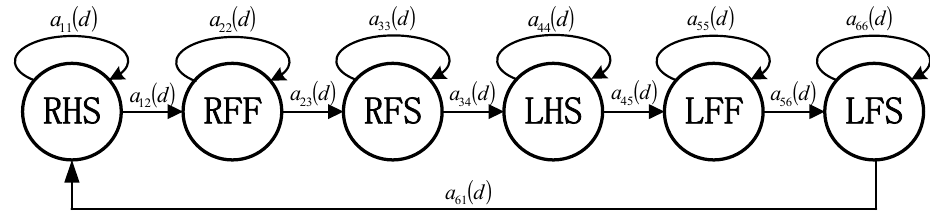
Figure 11. HMM model topology diagram.